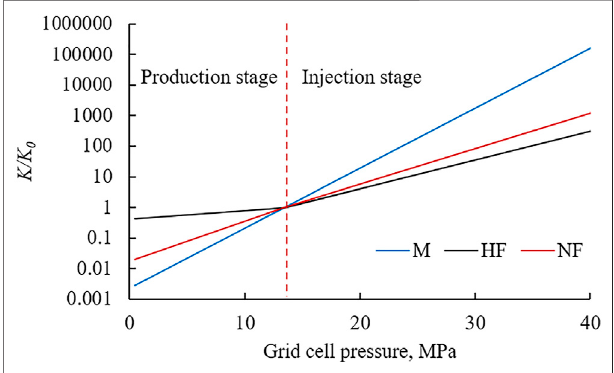
FIGURE 3 | Stress-dependent permeability during injection and production